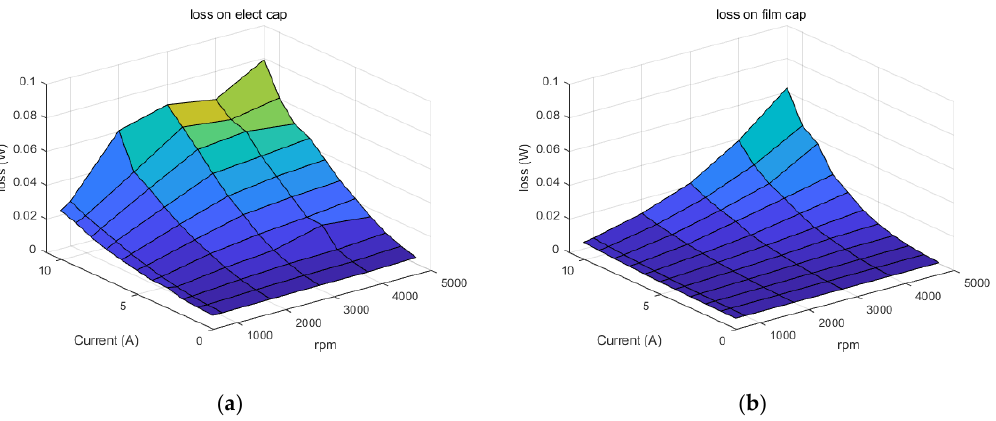
Figure 22. Capacitor losses in ( a ) electrolytic capacitor (88 μF ) and ( b ) film capacitor (10 μF ) as functions of motor speed and motor current of the electric compressor system.